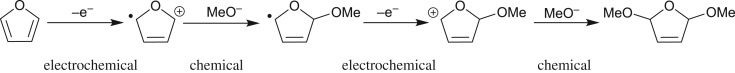
The ECEC mechanism proposed by Yoshida & Fueno [41] and Atobe and co-workers [42] for the electrosynthesis of 2,5-dimethoxy-2,5-dihydrofuran.